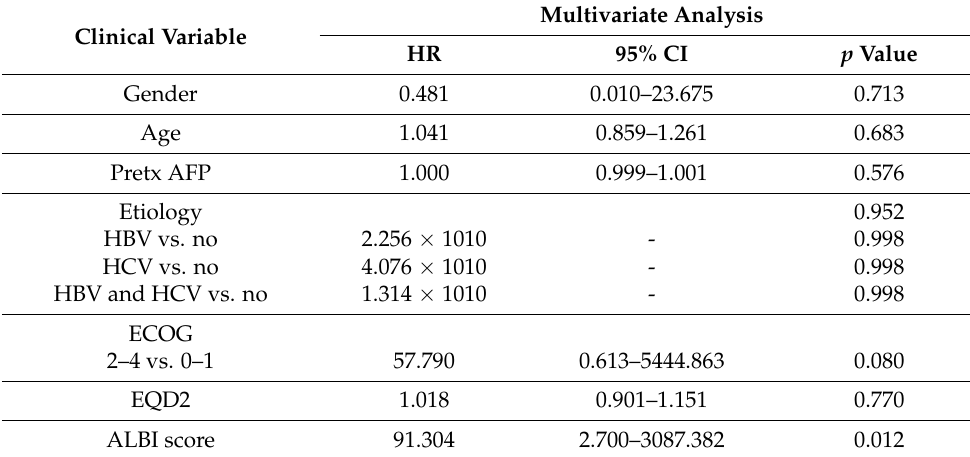
Multivariate Analysis